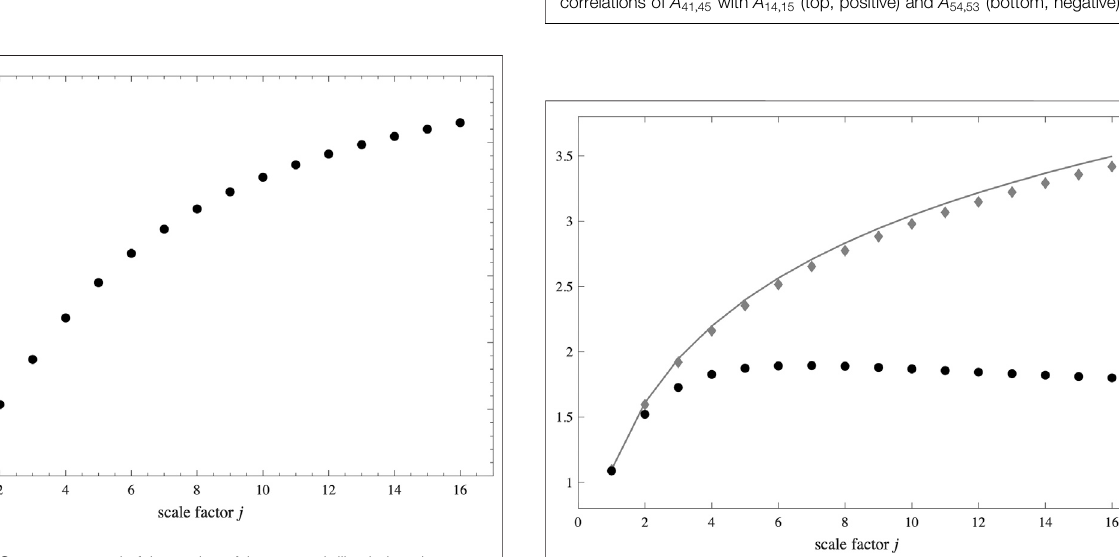
(cid:1)(cid:1)(cid:1)(cid:1) 〉 . ψ o